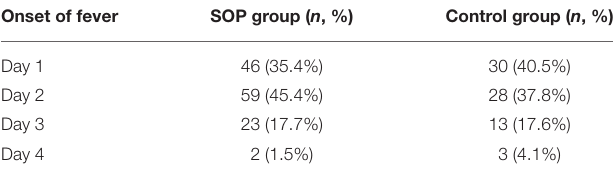
TABLE 2B | Days of fever